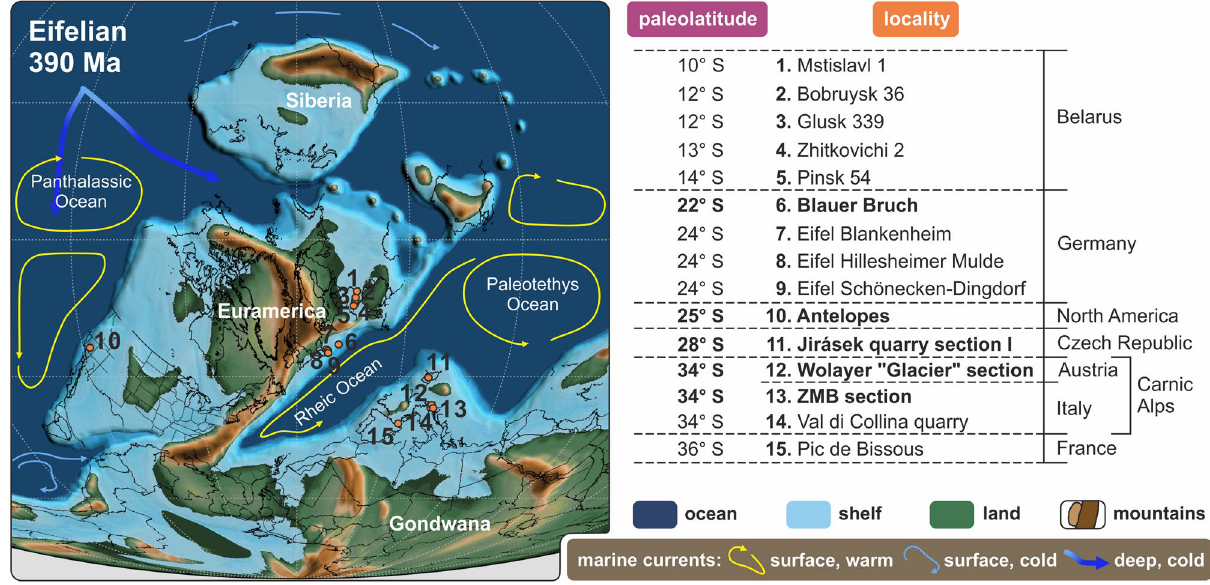
Figure 1. Paleolatitudinal position of published and newly studied localities during the Middle Devonian (late Eifelian to earliest Givetian). Localities reflecting more open marine conditions are marked in bold. Eifelian paleogeographic reconstruction modified after Scotese 33